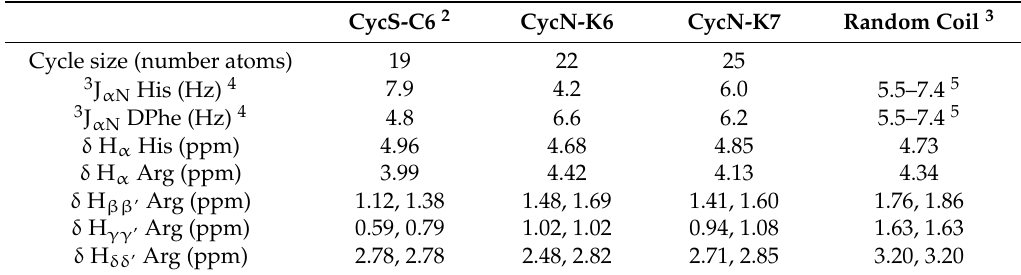
Table 2. Distinctive NMR parameters in peptides CycS-C6 , CycN-K7 , and CycN-K6 1 .